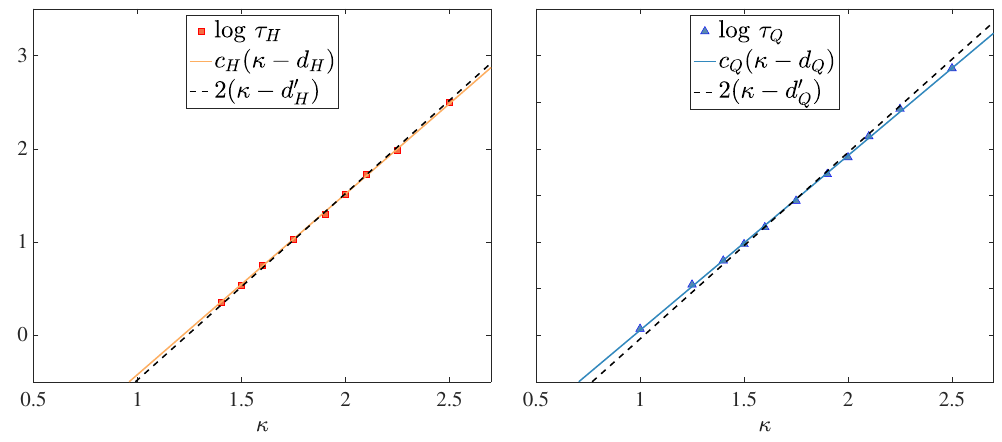
Figure 8 . The coefficients log τ H , log τ Q as functions of κ . The solid lines represent the best linear fits of the points. Fitting parameters are given in tables 9, appendix C and suggest the functions log τ ( κ ) and log τ ( κ ) are lines of slope 1 . 94 ± 0 . 03 and 1 . 88 ± 0 . 03 , respectively. The dashed H Q lines are instead obtained by fixing the slope to 2, and fitting only the intercepts and the resulting coefficients for the two fitting functions 2( κ − d 0 ) and 2( κ − d 0 ) are d 0 = 1 . 24 ± 0 . 01 (with H Q H = 1 . 02 ± 0 . 02 (with R 2 = 0 . 9951 ), R 2 = 0 . 9986 ) and d 0 Q